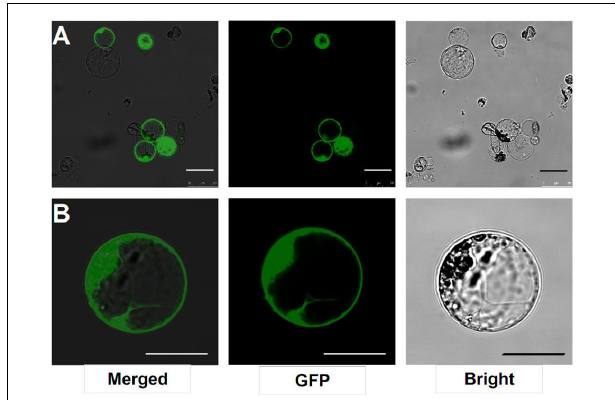
FIGURE 3 | Transient expression GFP-pUC19 in L. japonicus MG20 root protoplasts. (A) Detection of transfection efficiency by expression of vector 2 × 35S::GFP-pUC19. More than 60% of root protoplasts were transfected successfully with the GFP reporter. (B) Detail of expression patterns in the root protoplasts transfection by 2 × 35S::GFP-pUC19 are shown under Confocal microscopy (Leica TCS SP8). Scale bars = 25 µ m.